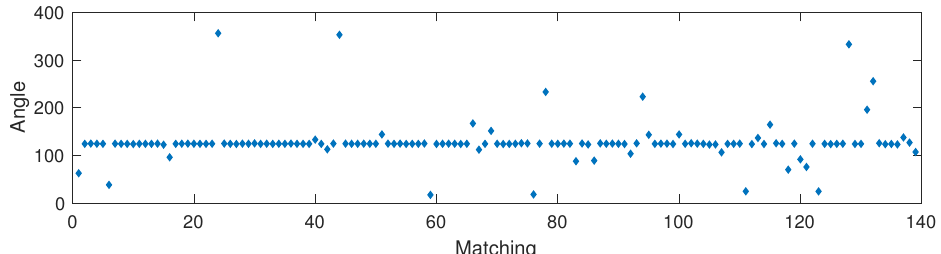
Figure 7. Angular differences between the direction between each landmark in the reference image and the center of the image and the direction between the matched landmark in the test image and the center of the